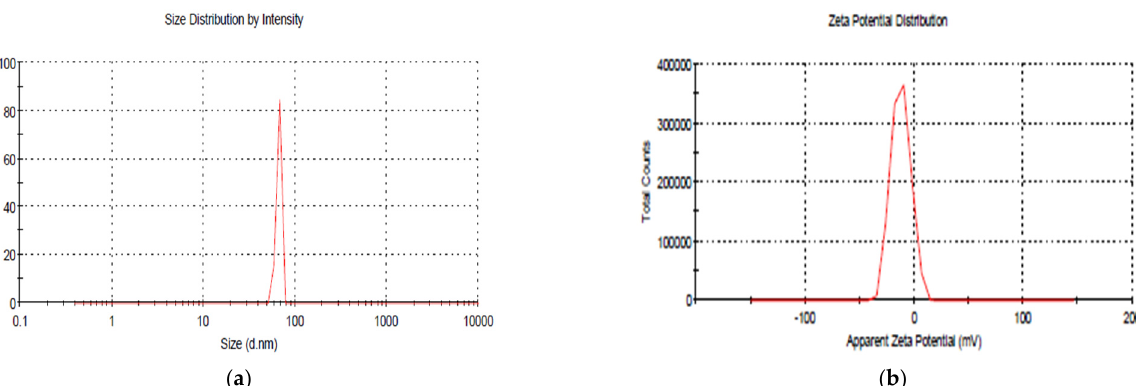
Figure 2. Dynamic light scattering (DLS) analysis of CSCRG nanoparticles. ( a ) Size of blank NPs. ( b ) Zeta potential of blank NPs.